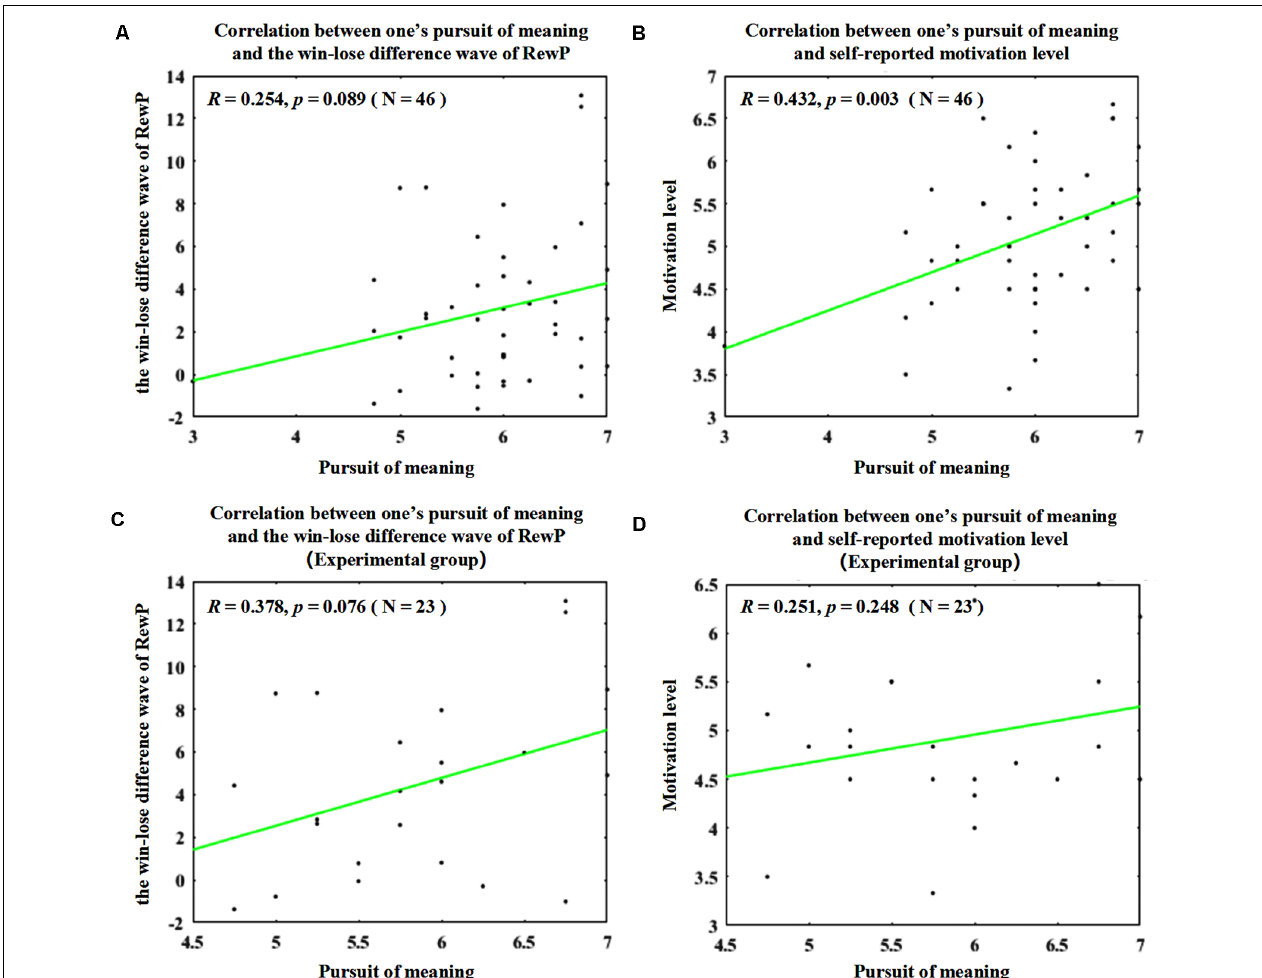
FIGURE 3 | Scatter diagrams and results of the correlation analyses. (A) Correlation between one’s scores in the pursuit of meaning scale and the amplitudes of reward positivity (RewP) in the win–lose difference wave. (B) Significant correlation between one’s scores in the pursuit of meaning scale and the self-reported motivation level measured by the task engagement scale. (C) Correlation between one’s scores in the pursuit of meaning scale and the amplitudes of RewP in the win–lose difference wave (experimental group participants only). (D) Correlation between one’s scores in the pursuit of meaning scale and the self-reported motivation level measured by the task engagement scale (experimental group participants